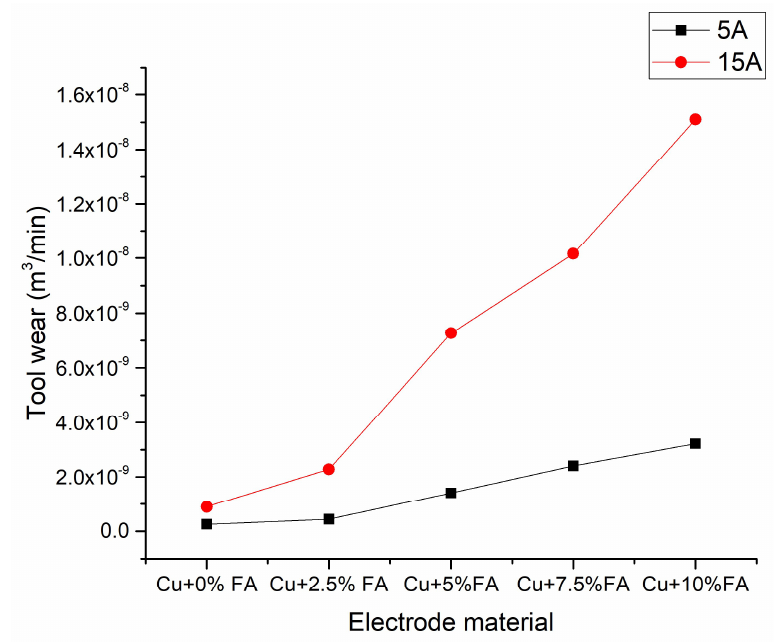
Figure 6. Effect of electrode material and current on tool wear.